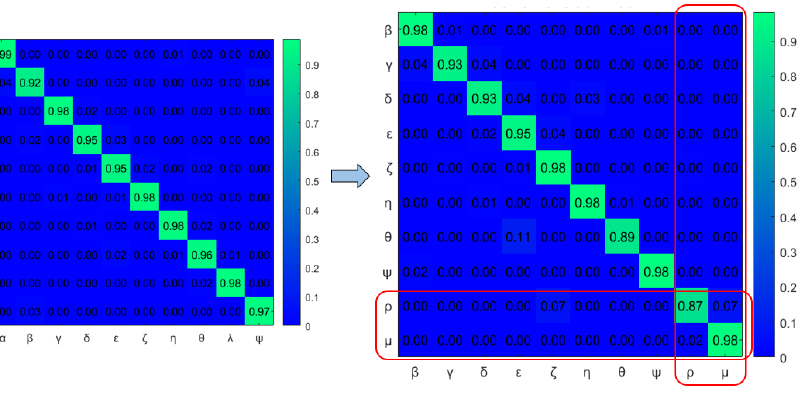
Figure 25. Comparison of joint transition probability matrices between incrementally learned model M 2 and previously learned